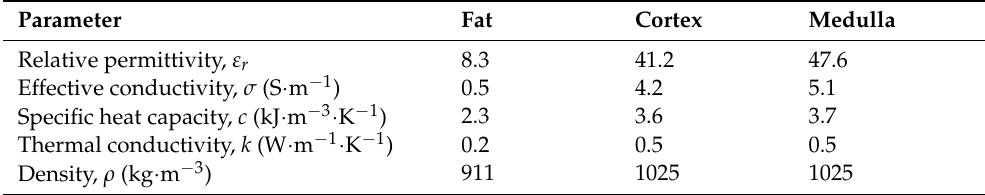
Table 1. Tissue dielectric and thermal properties at 25 ◦ C employed in the numerical simulations. Relative permittivity ( ε r ) and effective conductivity ( σ (S · m − 1 )) of cortex and medulla at 5.8 GHz refer to the mean values of dielectric data reported in